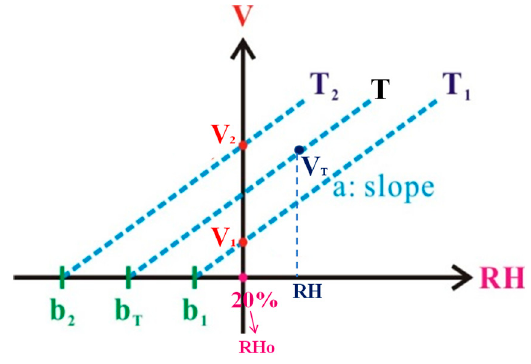
Figure 9. Relationship between voltage and RH at different temperatures.